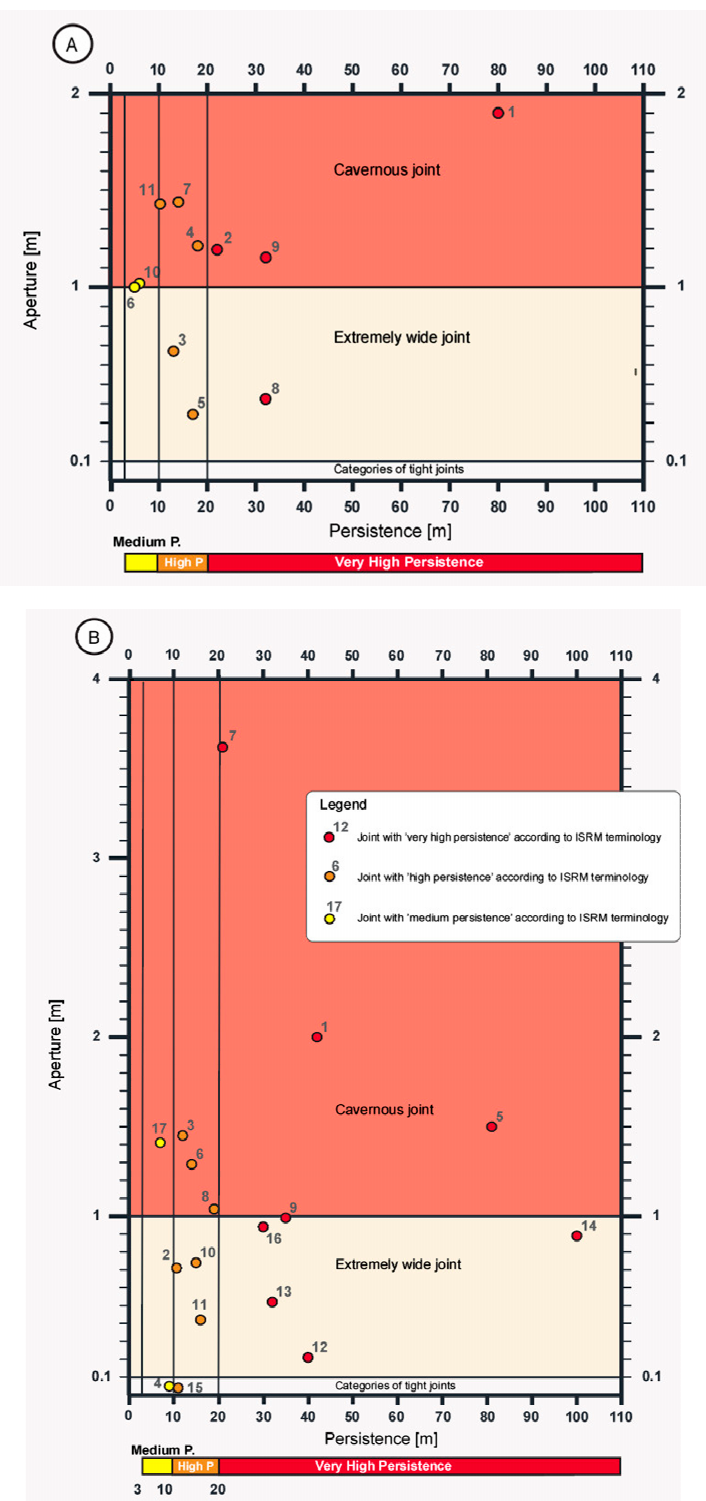
Figure 11. ( A ) Oblique view of complex network of discontinuities located in the western part of Marfa Ridge; ( B ) Spot on the western part of Il-Qarraba caprock where Rock mass # II, Rock mass # III, and Rock mass # IV are partially isolated by persistent joints; and ( C ) UAV-DP derived map of complex network of discontinuities.